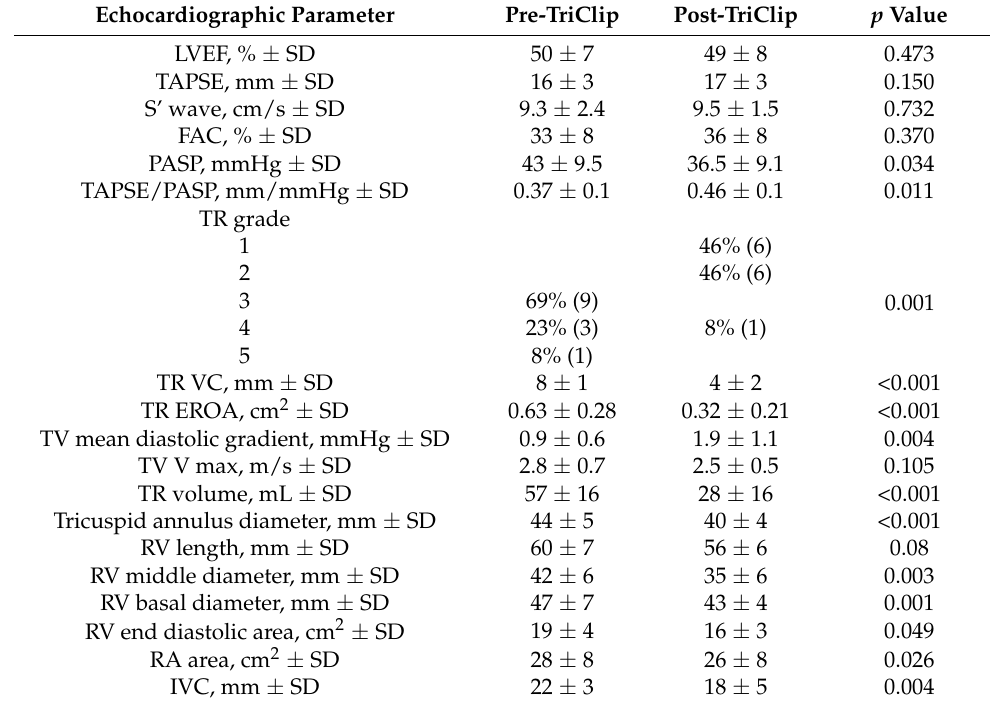
Table 2. Echocardiographic data of n.13 patients between baseline and before hospital discharge.